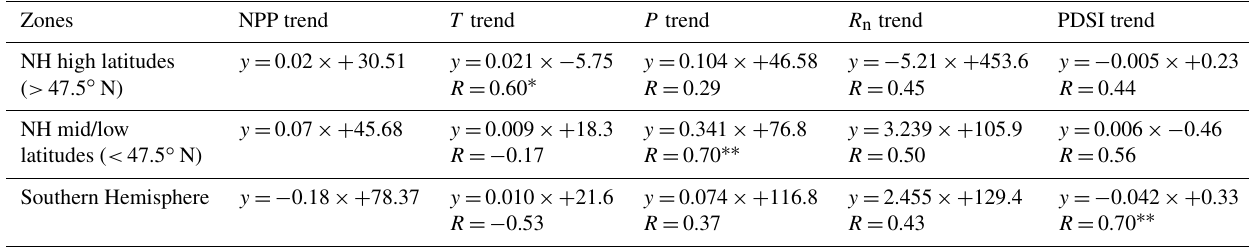
Table 1. Correlations between NPP and climatic variables for both hemispheres.